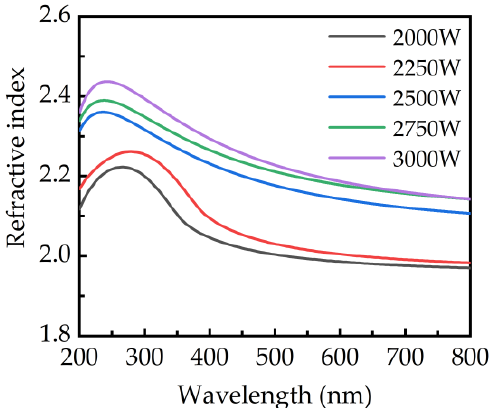
Figure 8. The refractive index of GaN films obtained at different plasma powers.